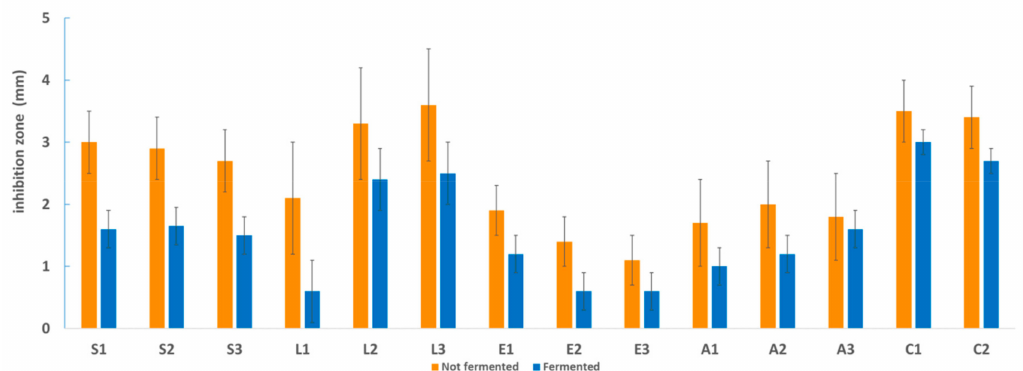
Figure 5. Antimicrobial activity of extracts from nonfermented and fermented samples (average values) toward each strain of foodborne pathogenic bacteria: Salmonella spp. (S1: S. enterica ATCC 14028; S2: S. enterica serotype Rissen ; and S3: Salmonella spp. suini), Listeria monocytogenes (L1: LM30; L2: LMG 21264; and L3: LMG 13305), Escherichia coli (E1: DSM 9025; E2: DSM 10973; and E3: POM 1048), Staphylococcus aureus (A1: NCTC 9393; A2: ATCC 6538; and A3: ATCC 19095), and Bacillus cereus (C1: 31; C2: